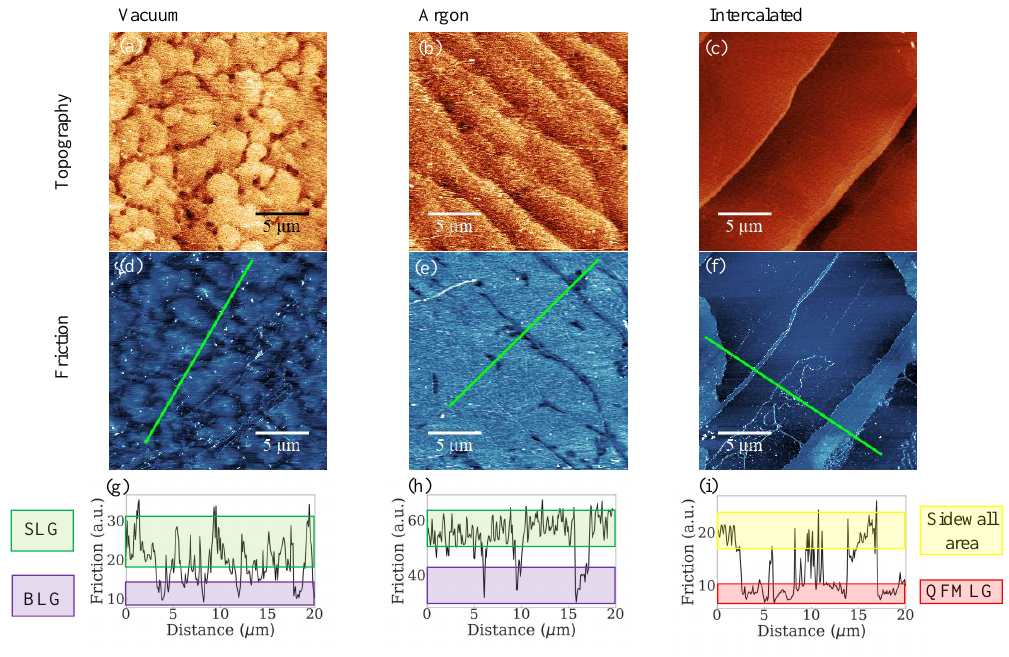
Figure 6. The topographies (20 × 20 µ m 2 ) of investigated samples are depicted in graphs ( a – c ) and corresponding friction force maps are shown in graphs ( d – f ). The profiles ( g – i ) of friction force maps (green lines) demonstrate the SLG, BLG, QFMLG and sidewall